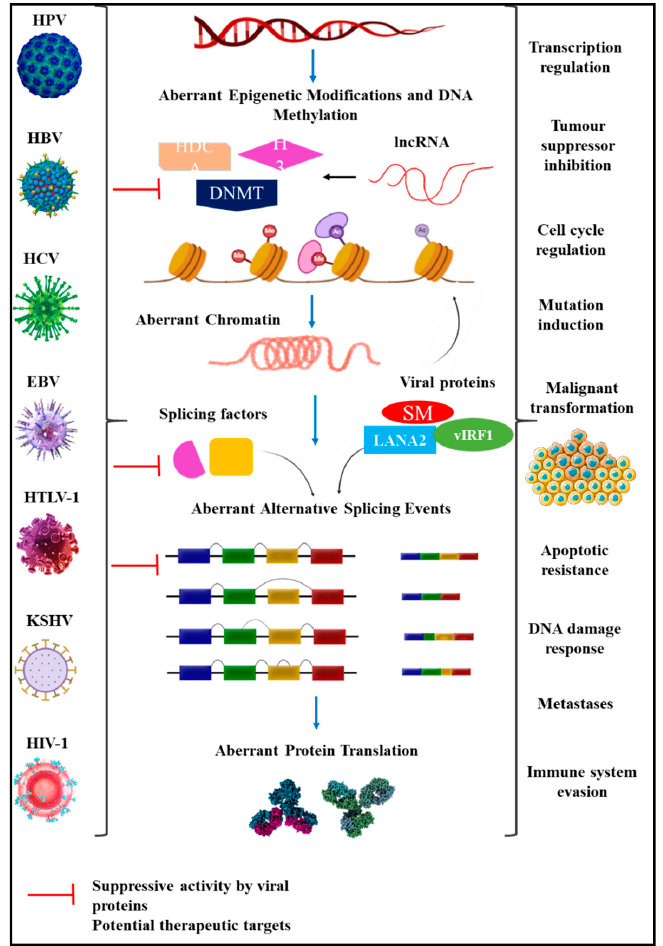
Figure 9. Summary of virally-induced carcinoma through global transcriptomic regulation. HPV, HBV, HCV, EBV, HTLV-1, KSHV and HIV-1 hijack epigenetic and splicing machinery to